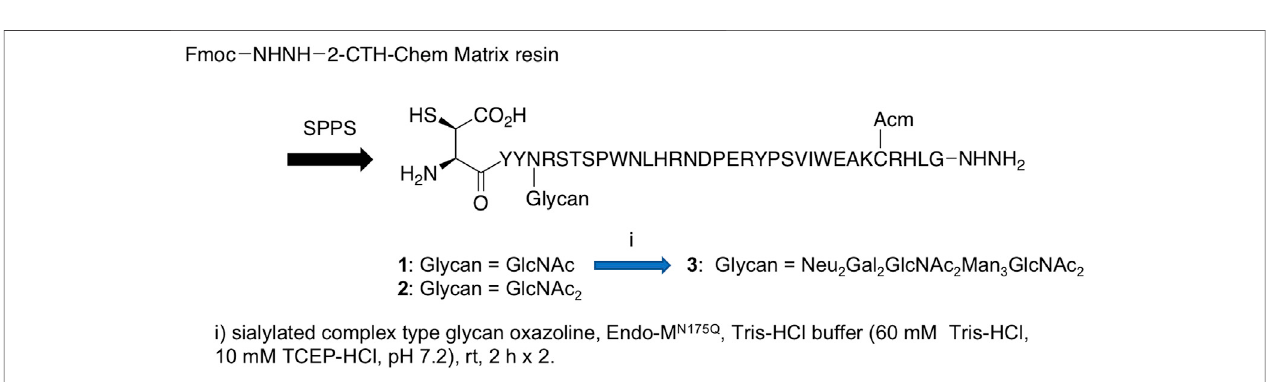
FIGURE 15 | Preparation of IL-17A glycopeptides.